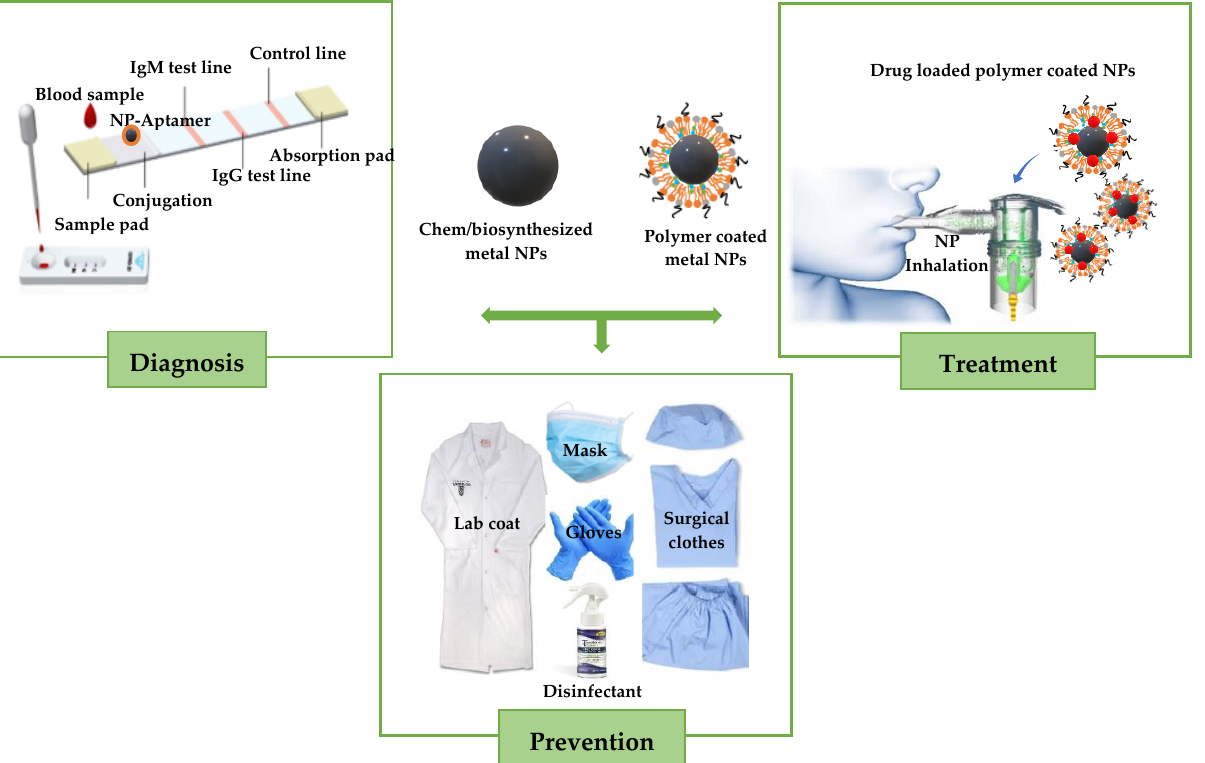
Figure 5. Schematic illustrations of the applications of metal nanoparticles against COVID-19/SARS- CoV-2.